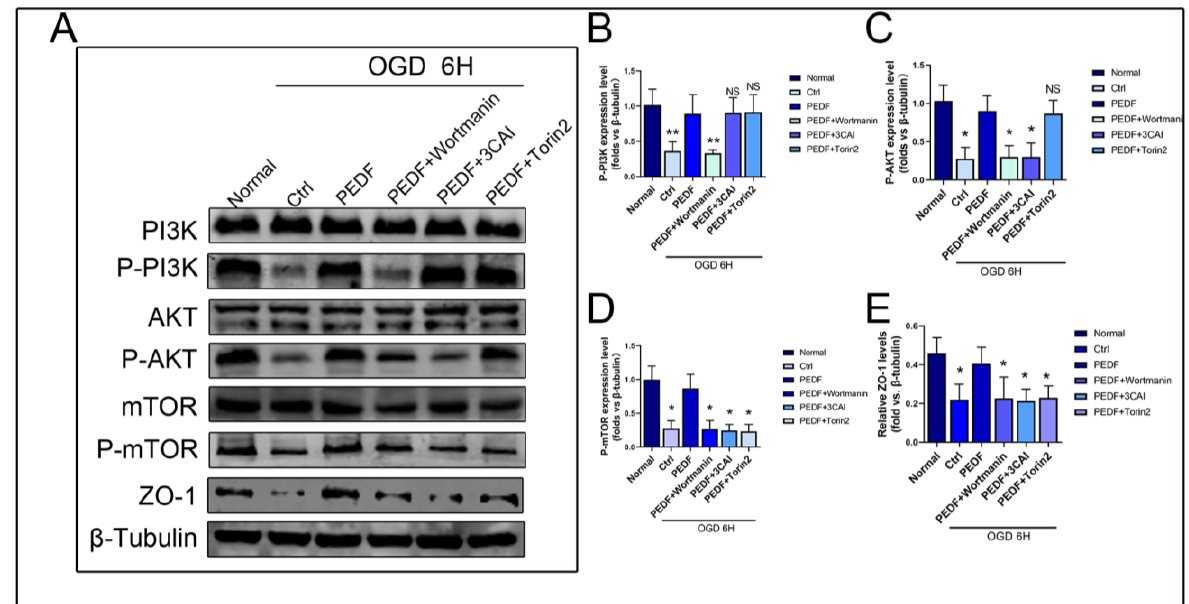
Figure 3. PEDF regulates the PI3K-AKT-mTOR pathway in endothelial cells during OGD. ( A ) Western blot to detect the effect of PEDF on phospho-PI3K, phospho-AKT and phospho-mTOR expressions. ( B – E ) Quantification of related protein expressions. Data are expressed as mean ± SD; n = 4; NS, no significant difference; * p < 0.05; ** p < 0.01.